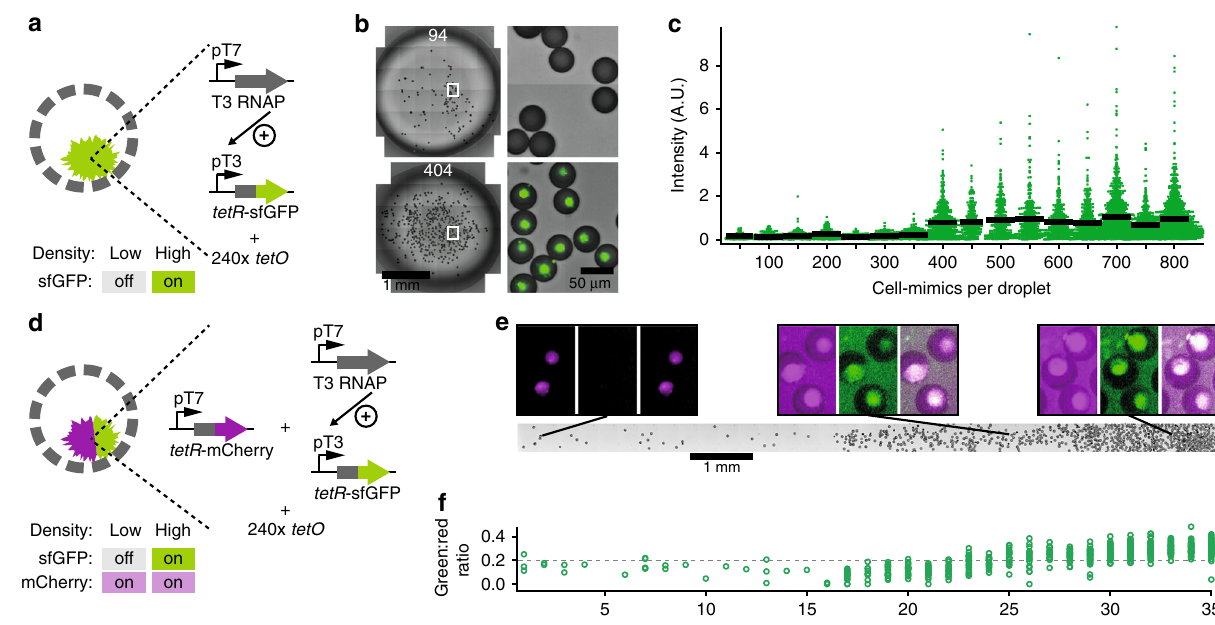
Fig. 4 Density sensing in populations of cell-mimics. a Arti fi cial quorum sensing cell-mimics contain T3 activation cascade DNA templates and 240× tetO plasmids. b Micrographs of cell-mimics in 4.5 µ l droplets of TX-TL (left). The number of cell-mimics is indicated. Enlarged regions (indicated by white boxes) show presence and absence of fl uorescence (green) in hydrogel nuclei after 3 h of expression. c Scatter dot plot of fl uorescence intensities in individual cell- mimics at different densities. Each density category combines data in increments of 50 cell-mimics per droplet and contains data from at least 156 cell-mimics (Methods). Black bars show average fl uorescence. d A 2-color response to density is achieved by adding a constitutively expressed reporter (pT7- tetR -mCherry), which is on independent of density. e 2-color density sensors were spread at increasing density in an elongated chamber (bright fi eld image, bottom). Panels above show magni fi ed fl uorescence images of indicated regions (mCherry fl uorescence: magenta, left; sfGFP fl uorescence: green, middle; merge of fl uorescence channels: right). Images in each channel are window leveled to the same values and have a width of 70 µ m. f Ratio between sfGFP to mCherry fl uorescence in individual hydrogel nuclei along the chamber. Positions correspond to tile regions of the image